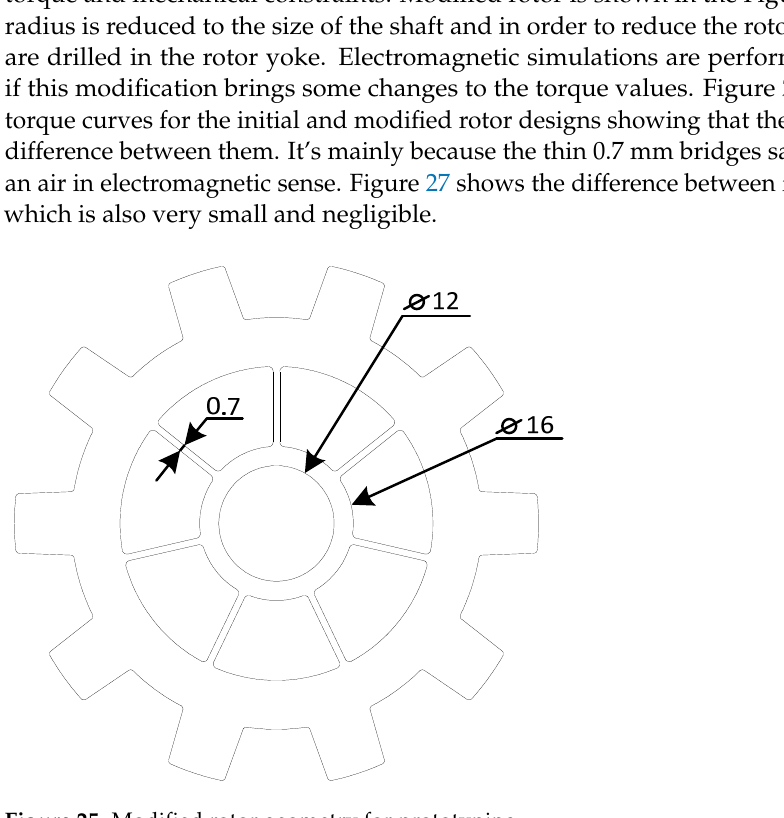
Figure 25. Modified rotor geometry for prototyping.